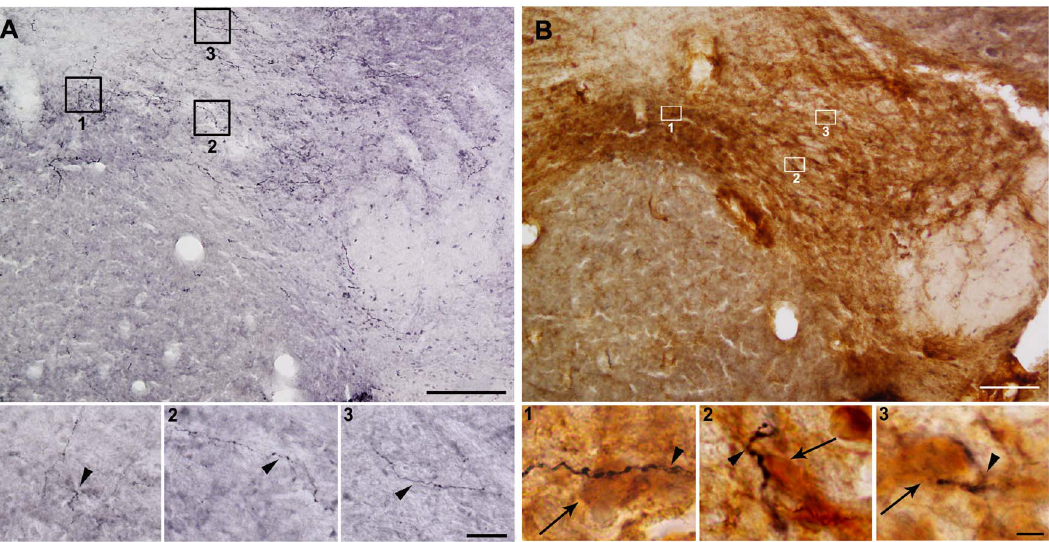
Figure 8. LHA orexin neurons innervate the PBP, PN and IF sub-regions of the VTA. Panel A and B show representative photomicrographs of VTA brain sections subjected to immunohistochemistry using either anti-orexin (purple/black staining) antisera alone or a combination of anti-TH (brown staining) and anti-orexin (purple/black staining) antiserum, respectively. Upper and bottom photomicrographs for each panel show low and high magnification images, respectively. Panels 1 show the IF, panels 2 show the PN, and panels 3 show the PBP sub-region of the VTA. Arrowheads point to orexin-IR fibers and arrows point to TH-IR cells contacted by orexin-IR fibers. Scale bars, 200 m m (low magnification), 20 m m (high magnification A), and 5 m m (high magnification A).